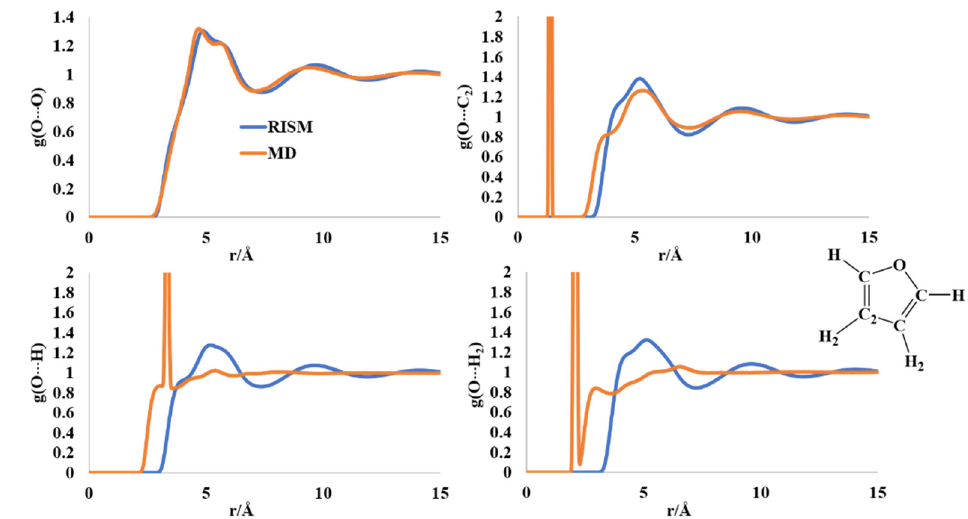
Figure 3. RISM- and MD-computed distribution functions for liquid furan.